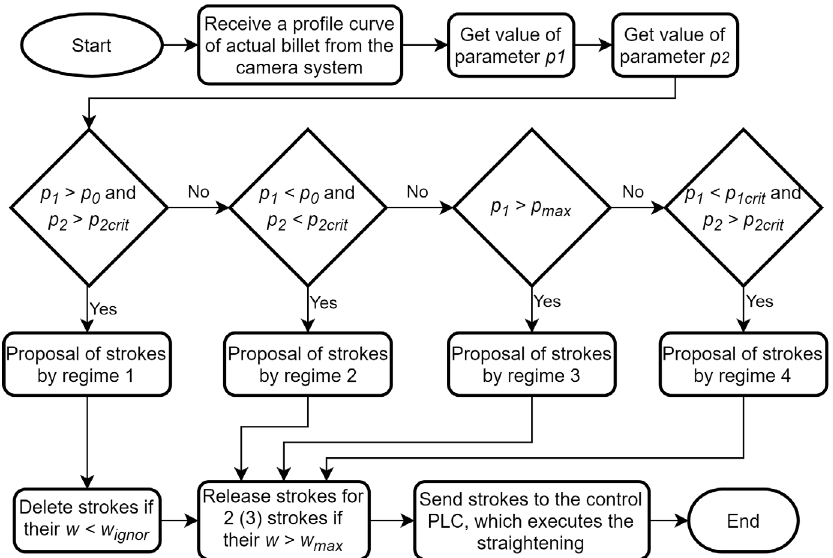
Figure 12. Flowchart of the straightening algorithm part proposing strokes (PLC—Programmable Logic Controller).